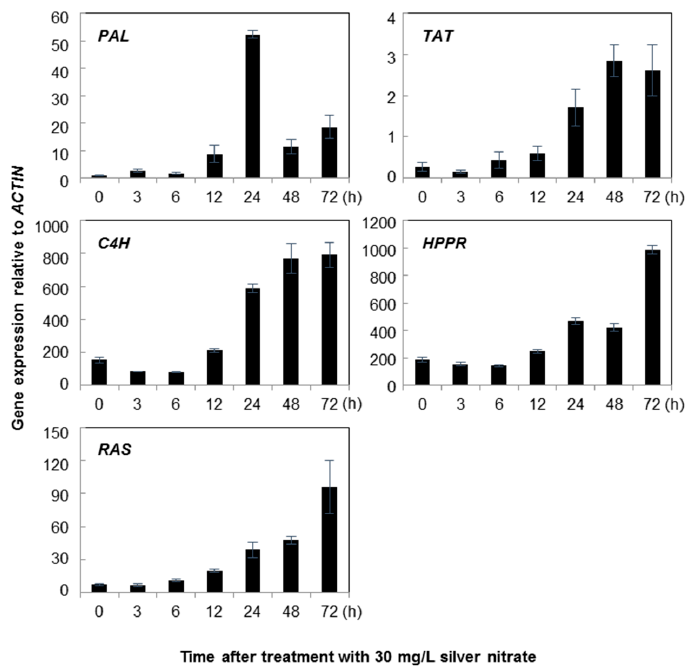
Figure 5. Time course of rosmarinic acid biosynthetic genes expression in Agastache rugosa calli treated with 30 mg/L silver nitrate. Transcription levels for each of the genes were analyzed relative to that of ACTIN . Error bars show standard deviation values.